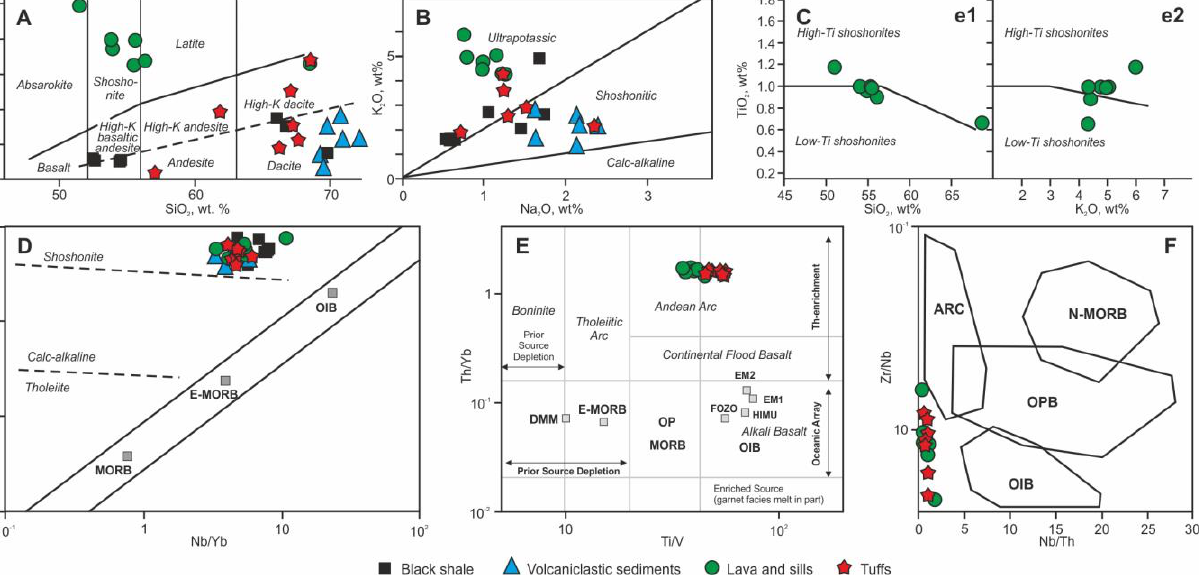
Figure 10. Geochemical systematics of volcanic (lava, sills and tuffs) and volcanic-sedimentary (black shale and volcaniclastic sediments) rocks from the Priorat DOQ region. ( A ) SiO 2 (wt.%) vs. K 2 O (wt.%). Fields for shoshonite, high-K and normal calc-alkaline volcanic rocks are derived from [56]. ( B ) K 2 O (wt.%) vs. Na 2 O (wt.%). Fields for ultrapotassic, shoshonitic and calc-alkaline volcanic series are modified from [57]. ( C ) TiO 2 (wt.%) vs. SiO 2 (wt.%) (e1) and TiO 2 (wt.%) vs. K 2 O (wt.%) (e2) tectonic discrimination diagrams for shoshonite magma series. Compositional fields for high-Ti (rift-related, late- or post-orogenic) and low-Ti (arc-related) shoshonites are derived from [58]. ( D ) Th/Nb vs. Nb/Yb. Mantle array, average values for depleted mind-ocean basalt (N-MORB), enriched mid-ocean ridge basalt (E-MORB), oceanic island basalt (OIB) and fields for tholeiite, calc-alkaline and shoshonite magma series are derived from [59]. ( E ) Th/Yb vs. Ti/V. All compositional fields are derived from [60]. Average values for depleted mid-ocean ridge mantle source (DMM), enriched mid-ocean ridge basalt (E-MORB) and various enriched mantle compo- nents (EM1, EM2, HIMU, FOZO) follow the nomenclature of [41] and references therein. OIB — oceanic island basalts, OP MORB — oceanic plateau mid-ocean ridge basalt. ( F ) Zr/Nb vs. Nb/Th. Fields for island arc basalts (ARC), depleted (normal) mid-ocean ridge basalts (N-MORB), ocean plateau basalts (OPB) and ocean island basalts (OIB) are derived from [61].